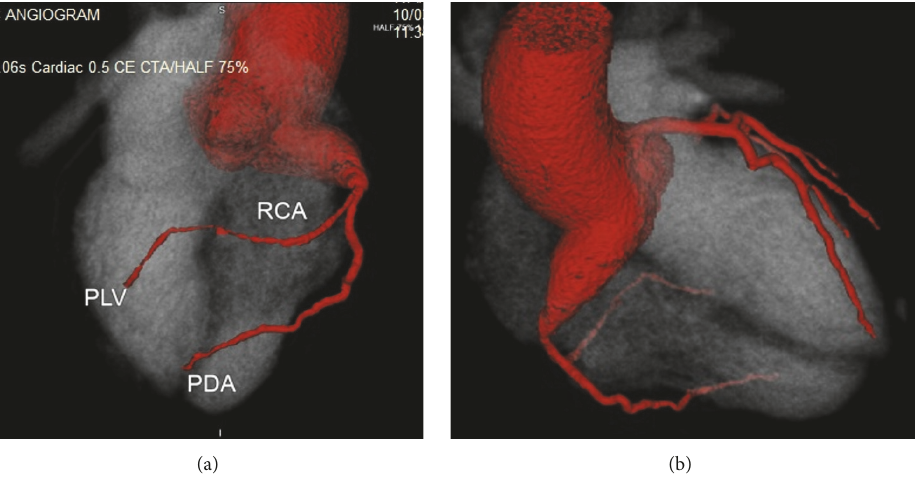
Figure 1: CT coronary angiography demonstrating right coronary sinus of Valsalva. Aneurysm viewed (a) anteriorly and (b) posteriorly.